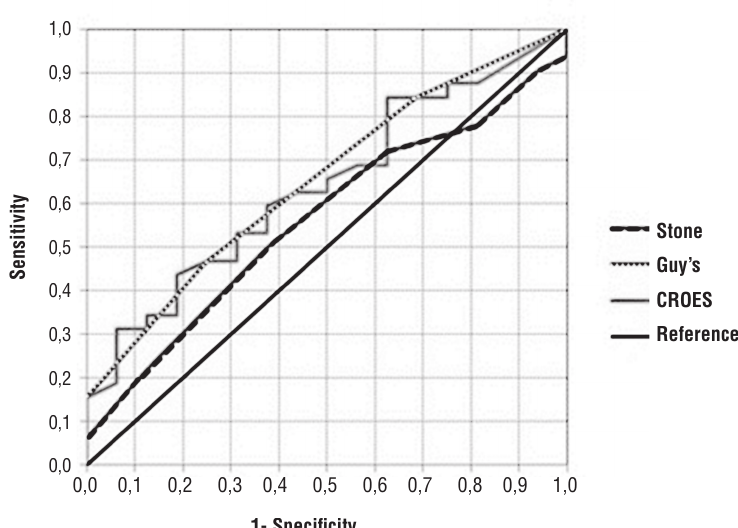
figure 3 – ROc curve for sTOnE score, Guy´s score, cROEs nomogram and